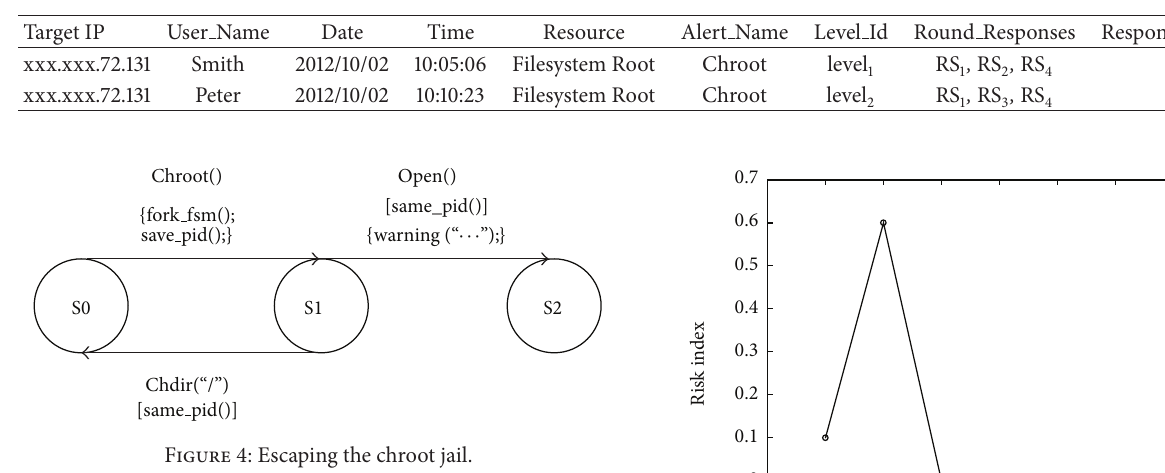
Table 3: Plans history database, after applying the first round of level